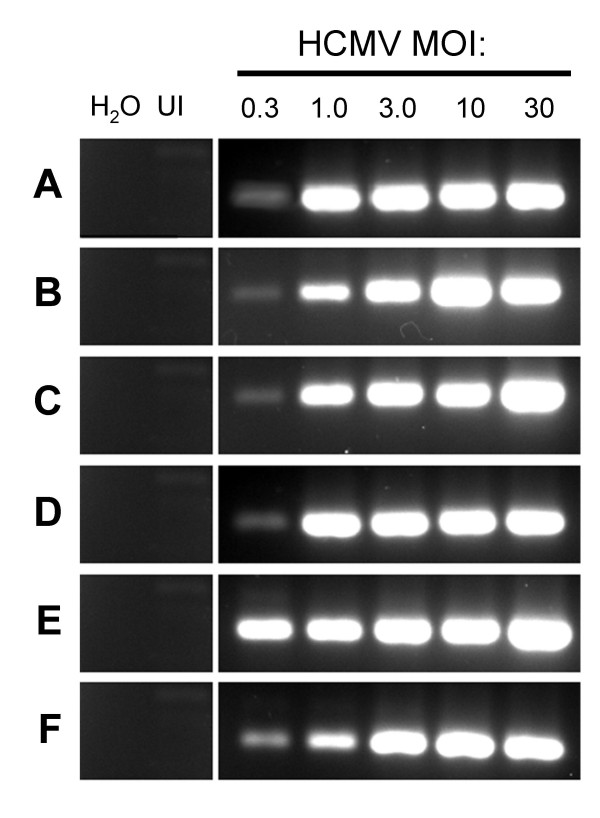
Inhibition of HCMV by IFN-α, IFN-β and/or IFN-γ is not a result of decreased viral entry into cells. Ethidium bromide-stained IE exon 4 PCR products amplified from HCMV-infected HFFs pre-treated with either vehicle (A) or 100 IU/ml of IFN-α (B), IFN-β (C), IFN-γ (D), IFN-α and IFN-γ (E) or IFN-β and IFN-γ (F). From left to right, PCR products were amplified from H2O control, 100 ng of uninfected (UI) HFF DNA or 100 ng of HCMV-infected HFF DNA harvested from cells inoculated for 2 h at MOIs of 0.3 to 30. GAPDH PCR products were run along side IE exon 4 PCR products and served as internal loading controls (data not shown).